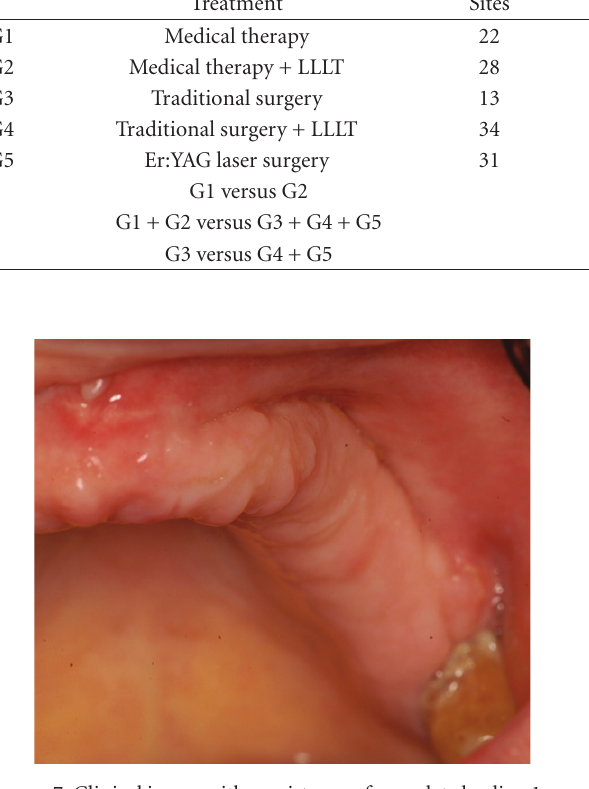
Figure 7: Clinical image with persistence of complete healing 1 year after surgery.